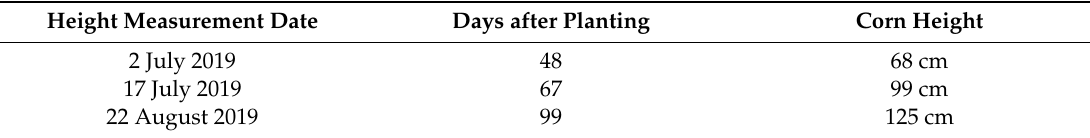
Table 2. Corn crop field measurements.